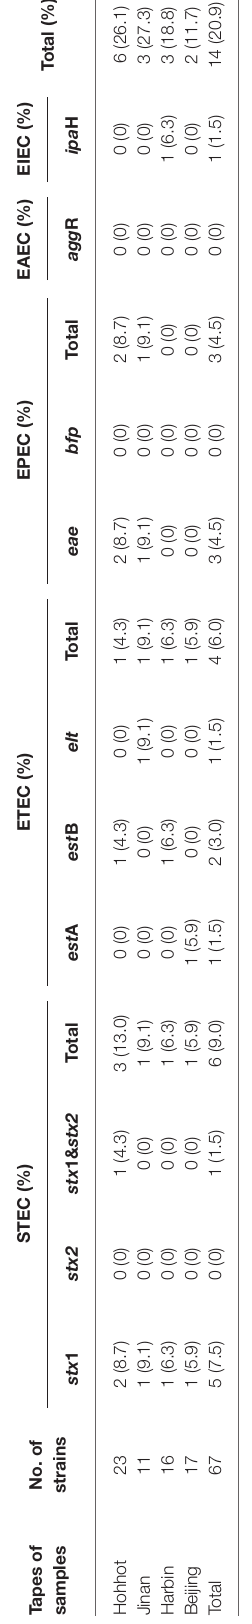
Table 3 . The prevalence of β -lactamase-encoding genes were 34.3% in 67 E. coli isolates and 45% in 40 β -lactam resistance E. coli isolates. The overall prevalences of bla SHV , bla TEM , bla CMY , and bla CTX-M genes among E. coli isolates, which was narrow spectrum extended-spectrum β -lactamase-encoding genes, β -lactamase-encoding genes, AmpC, and β -lactamase-encoding genes, were 1.5, 1.5, 10.4, and 20.9%, respectively. In